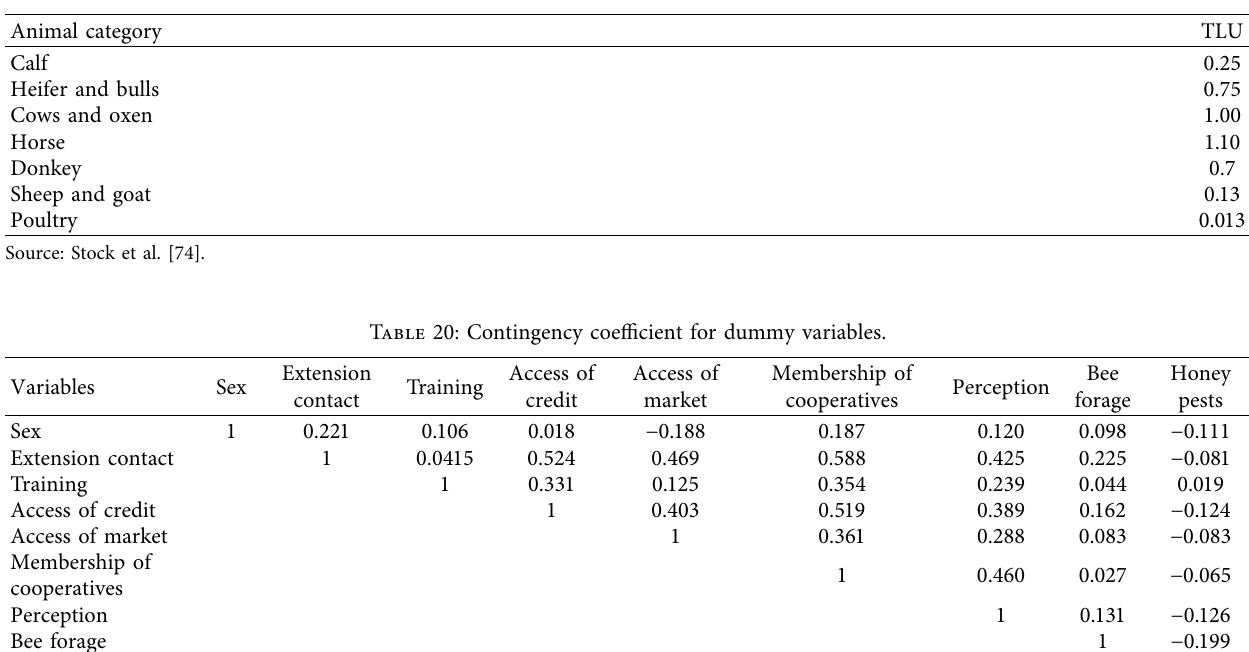
Table 19: Conversion factors used to calculate the TLU.